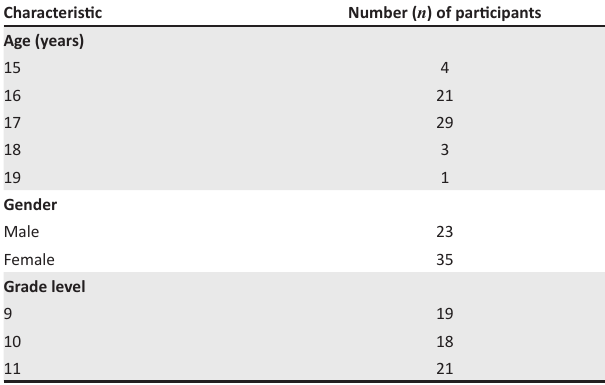
TABLE 1: Demographic profile of the youth participants ( n = 58).